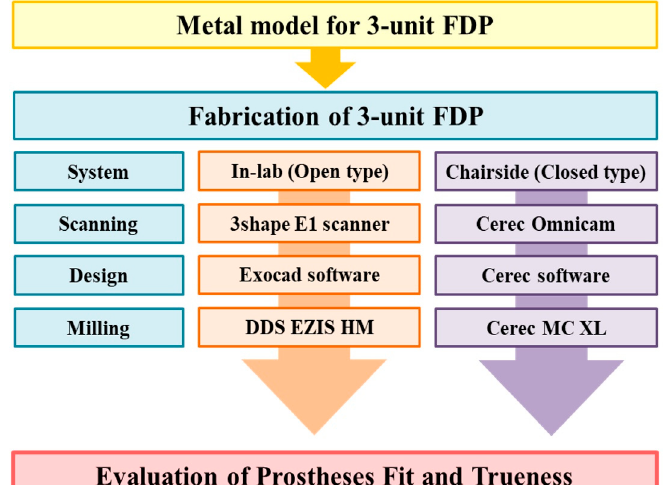
Figure 1. Experimental design.